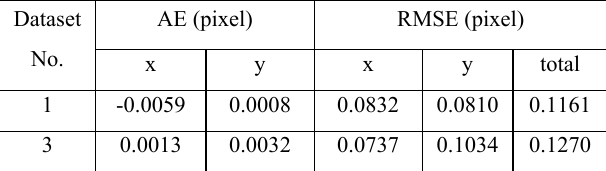
Table 4. B2-B3 registration accuracy after compensation